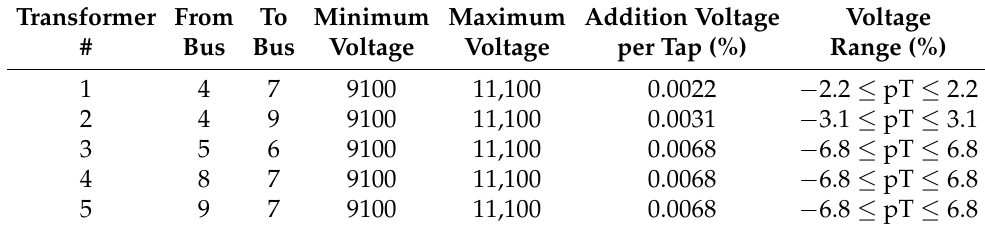
Table 5. Transformers characteristics of the IEEE 14-bus test system. Transformer From